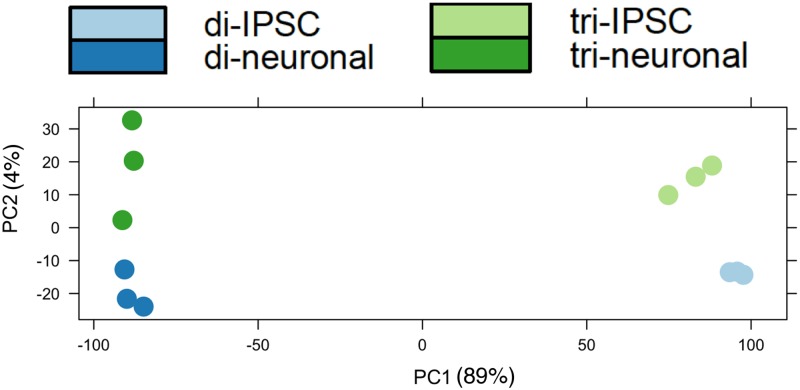
Principal component analysis of transcriptome datasets.Note principal component 1 clearly segregates iPSC from neuronal cultures, while component 2 partitions trisomic from disomic cells.